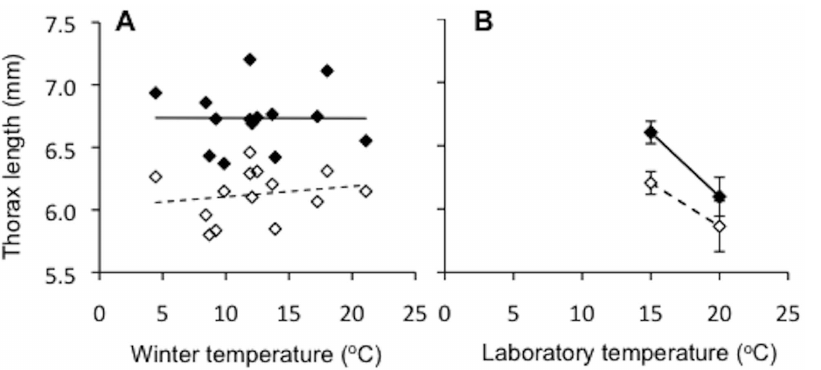
Figure 2. Discrepancies in thermal effects on body size. Average thorax length of (a) field-collected specimens with respect to average winter (May-September) temperature of source populations and (b) laboratory reared specimens, with respect to temperature treatment (Males = open diamonds; Females = closed diamonds). Error bars denote standard error of mean (SEM).